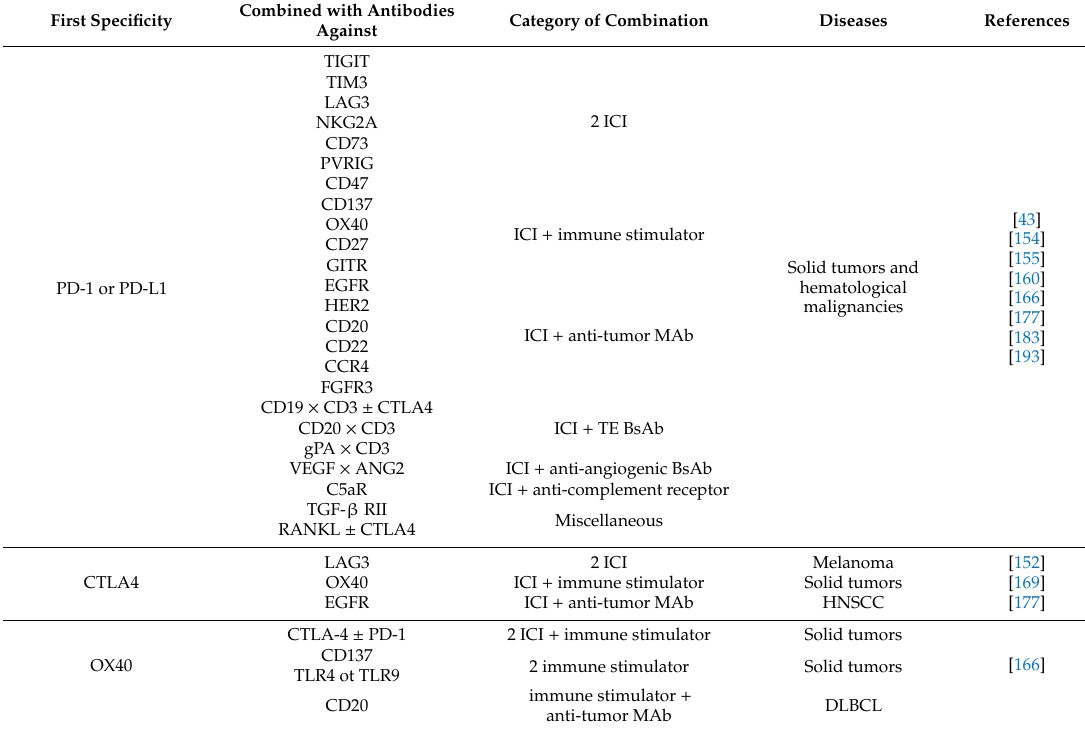
Table 6. Combinations of MAbs / BsAbs being tested in Phase I and II clinical